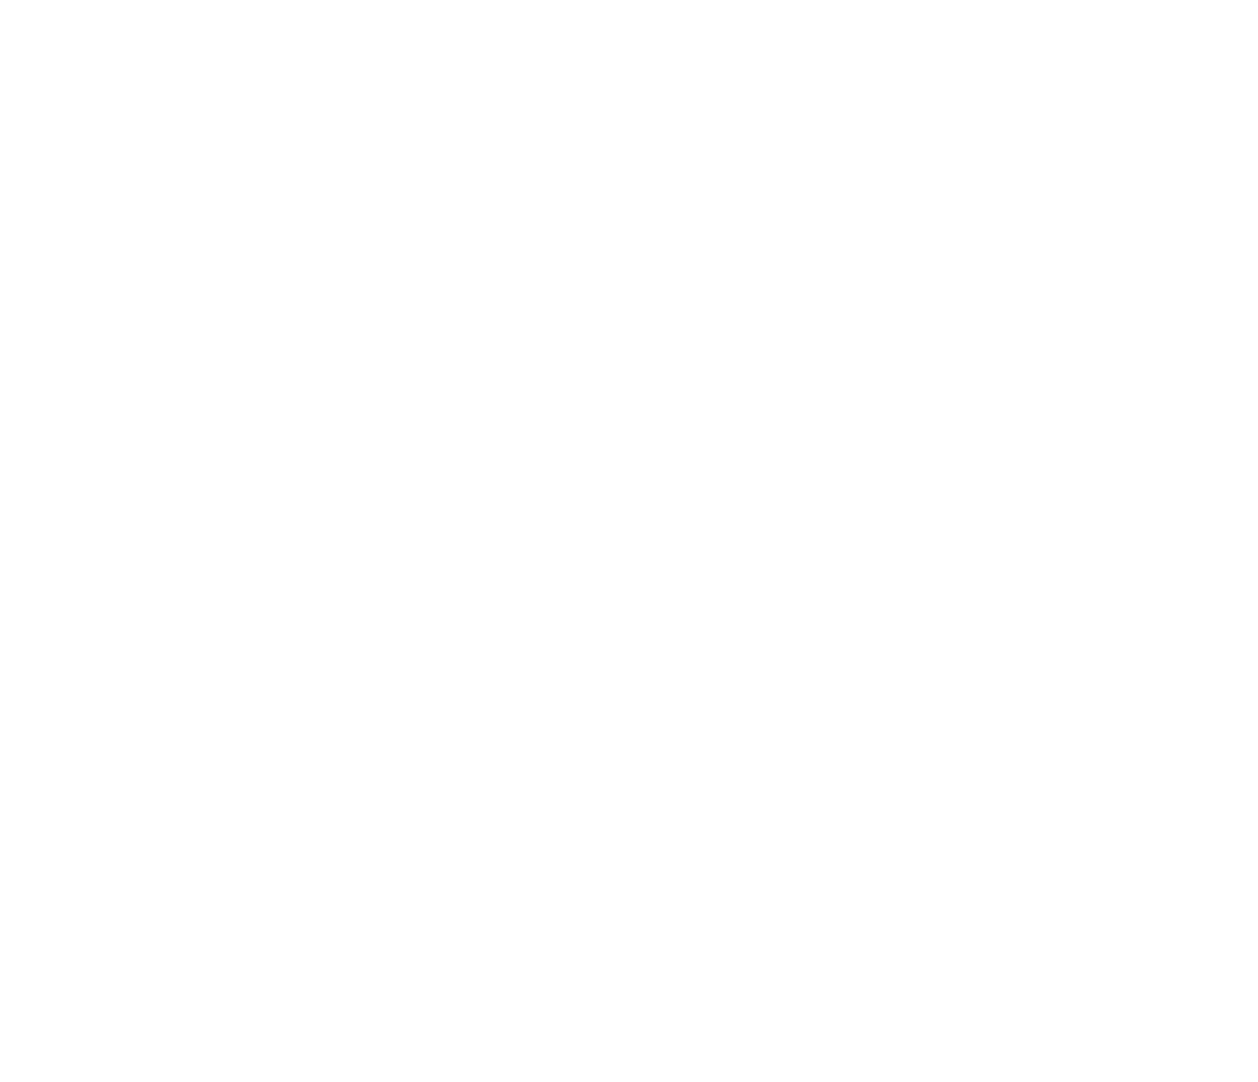
FIGUREA3 | Local release of stress due to the different cell division modes as in Figure 4 but for a feedback of 4. (A) Distribution of the total change in stress in the dividing cell and its nearest neighbors and the respective mean versus division mode (B)